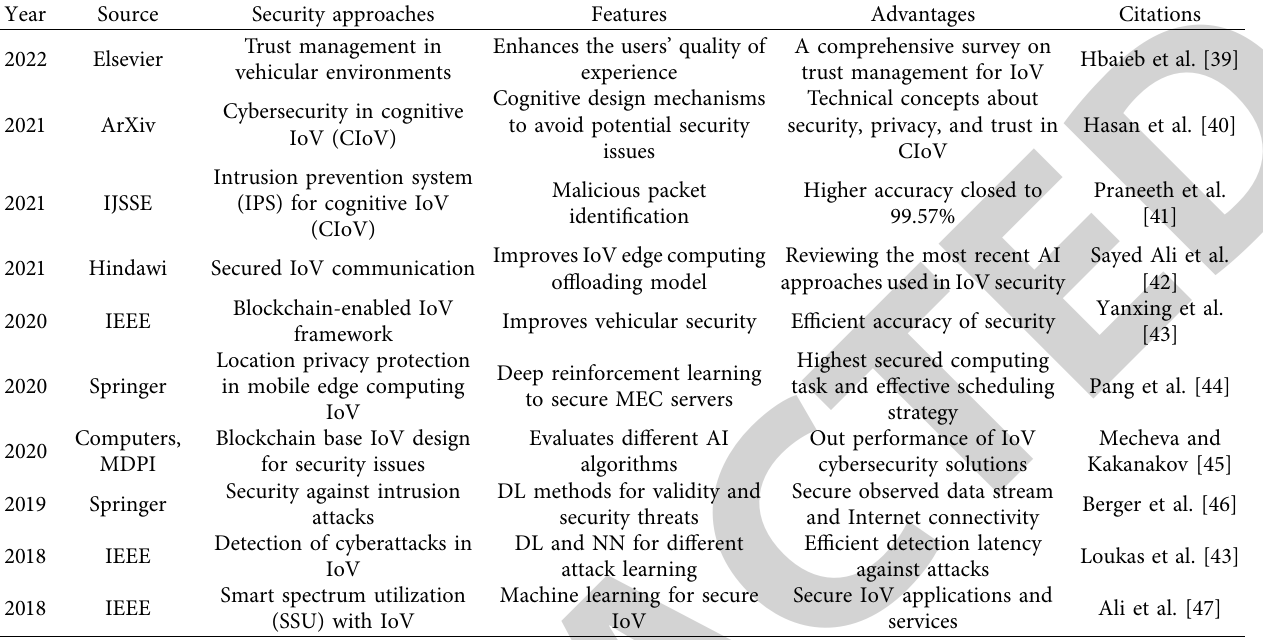
Table 1: Summary of deep learning applications in secure internet of